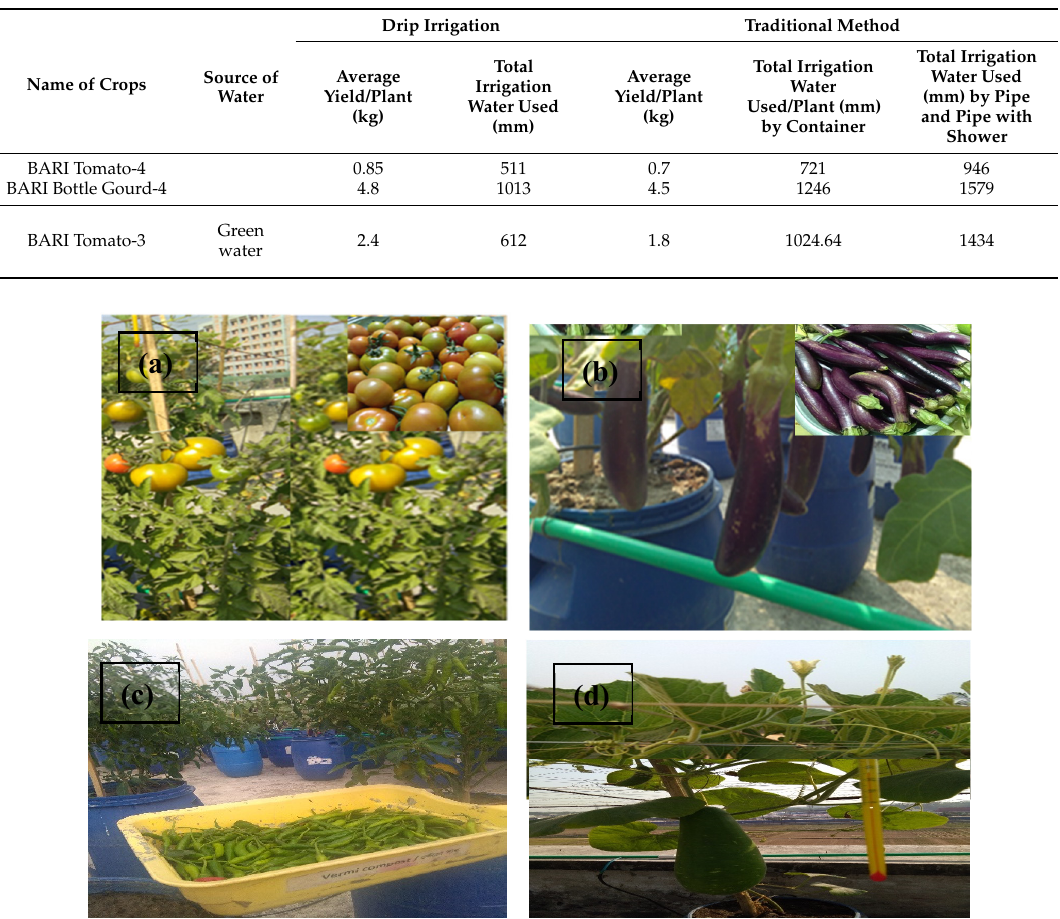
Figure 3. The yield scenario of ( a ) BARI Tomato-3, ( b ) BARI Brinjal-8, ( c ) Bogra Local Chili, and ( d ) BARI Bottlegourd-3 in the experimental URTA.